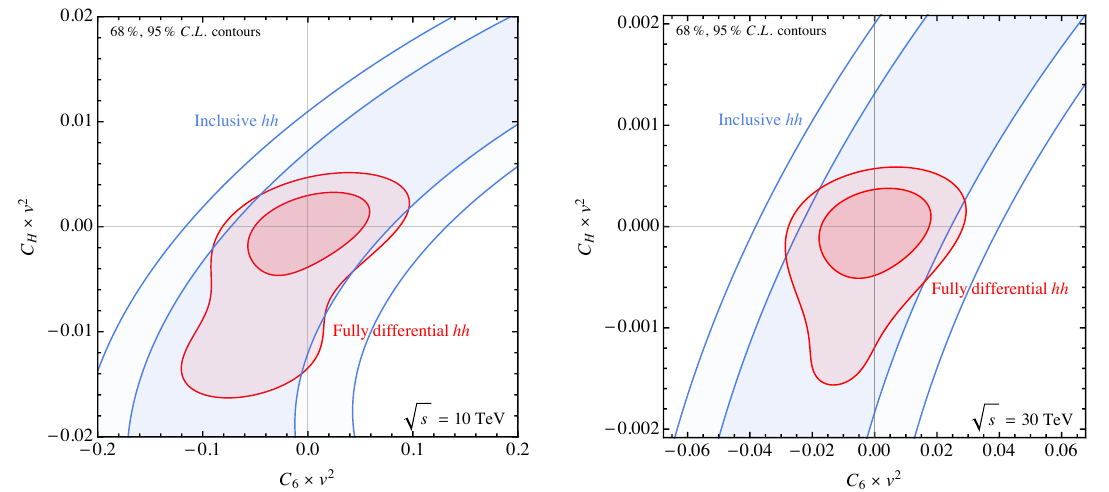
Figure 6 . Constraints on the Wilson coefficients C 6 and C H of eq. (3.2) from the inclusive hh → 4 b cross-section measurement (blue), and from its differential distribution in di-Higgs invariant mass M hh and Higgs transverse momentum p T,h (red). The contours indicate 68% and 95% C.L. constraints (2 d.o.f.). Left: E cm = 10 TeV. Right: E cm = 30